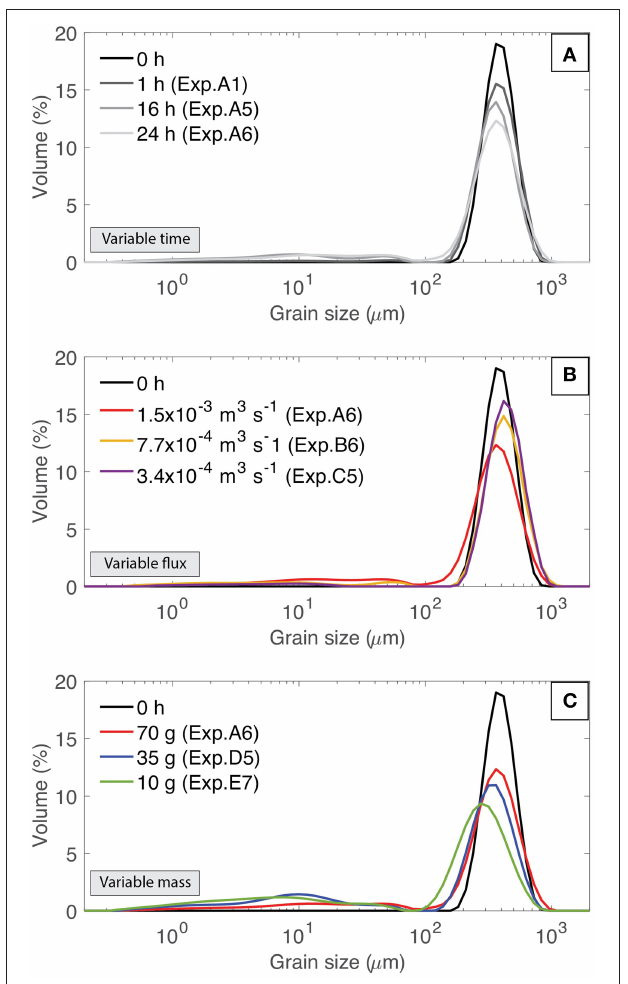
FIGURE 5 | Total grain size distributions of run products from a select number of experiments illustrating the effects of: (A) changing residence time ( t R ), (B) changing input gas flux (constant t R the input mass (constant t R